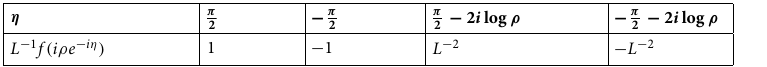
Table 4. The established correspondence based on Tables 2 and 3.